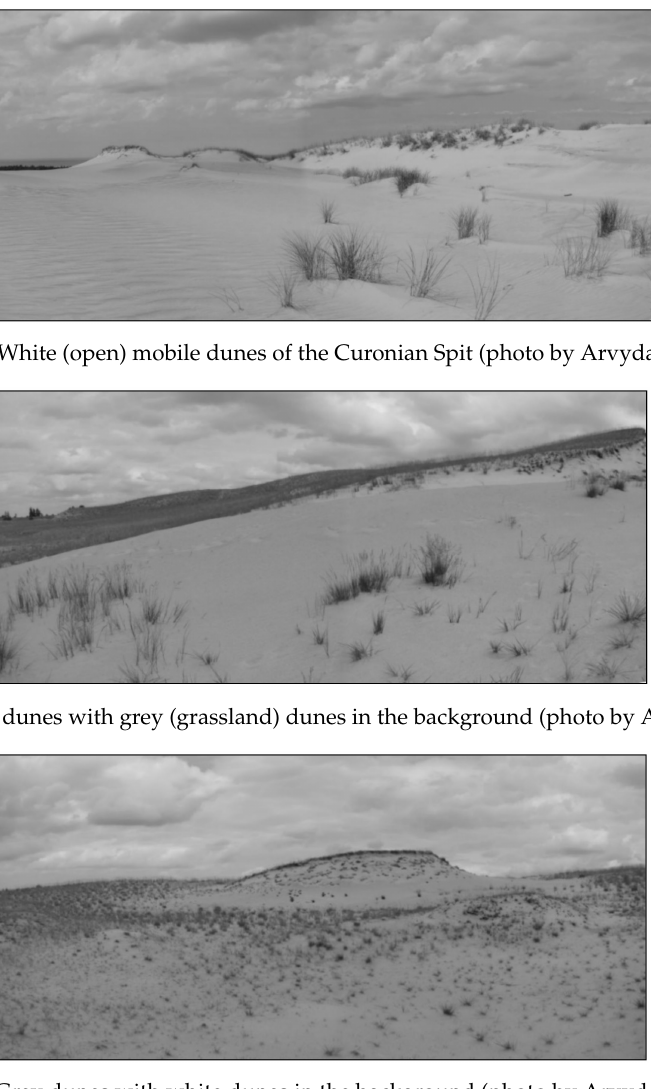
Figure 7. Grey dunes with white dunes in the background (photo by Arvydas